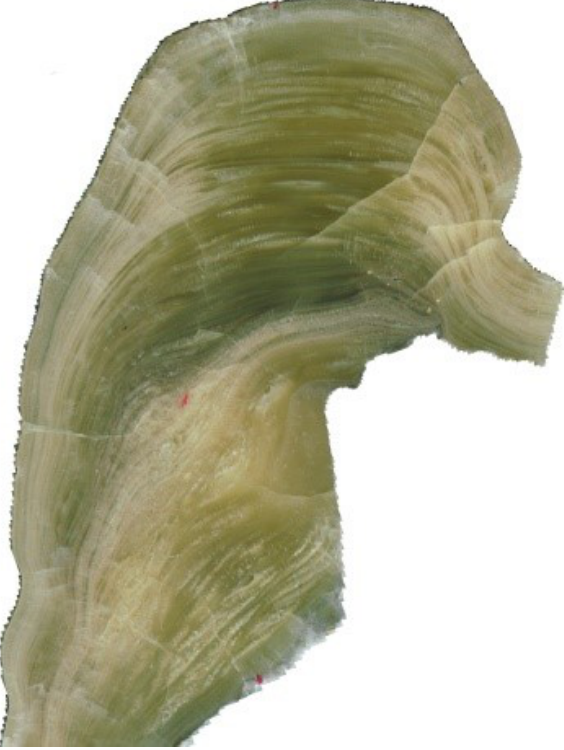
Figure 4. Polished longitudinal cross section of stalagmite ky1.